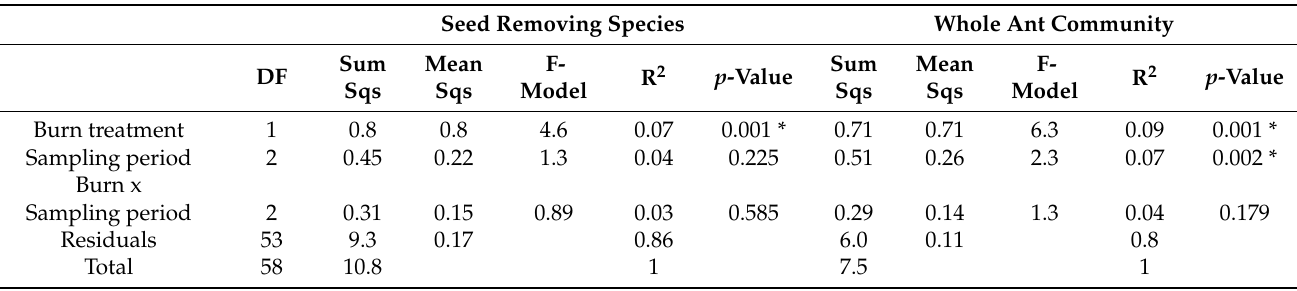
Figure 4. NMDS for ant community composition. Burn treatment is labeled “PB” for prescribed burn and “UB” for unburned. ( A ) Seed-removing species: species frequency of occurrence in transects using Bray–Curtis distance metric. ( B ) Overall community: species frequency of occurrence in transects using Bray–Curtis distance metric. Table 3. Non-parametric multivariate analyses of variance of leaf litter community composition.